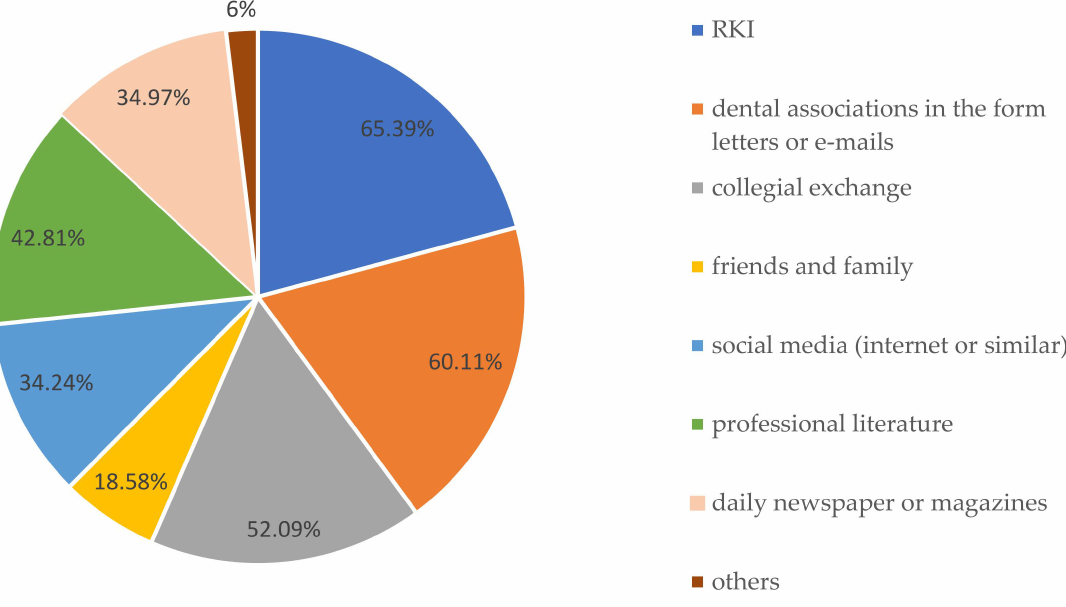
Figure 2. Information sources regarding